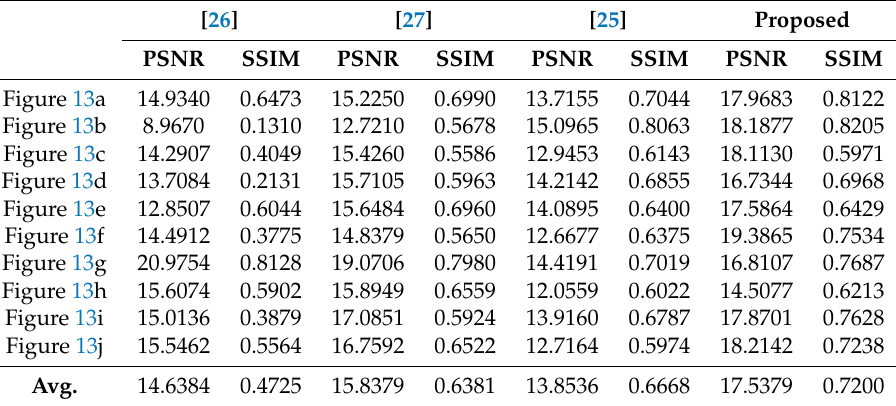
Figure 14. Resulting enhanced images using existing and proposed methods taking synthesized low-light images as the input: ( a ) ideal image [29], ( b ) synthesized low-light image, ( c ) histogram equalization (HE) [26], ( d ) Huang’s method [27], ( e ) Jiang’s method [25], and ( f ) the proposed method. Table 4. The objective assessments of the low-light image enhancement using the peak signal-to-noise ratio (PSNR) and the structural similarity index measure (SSIM)